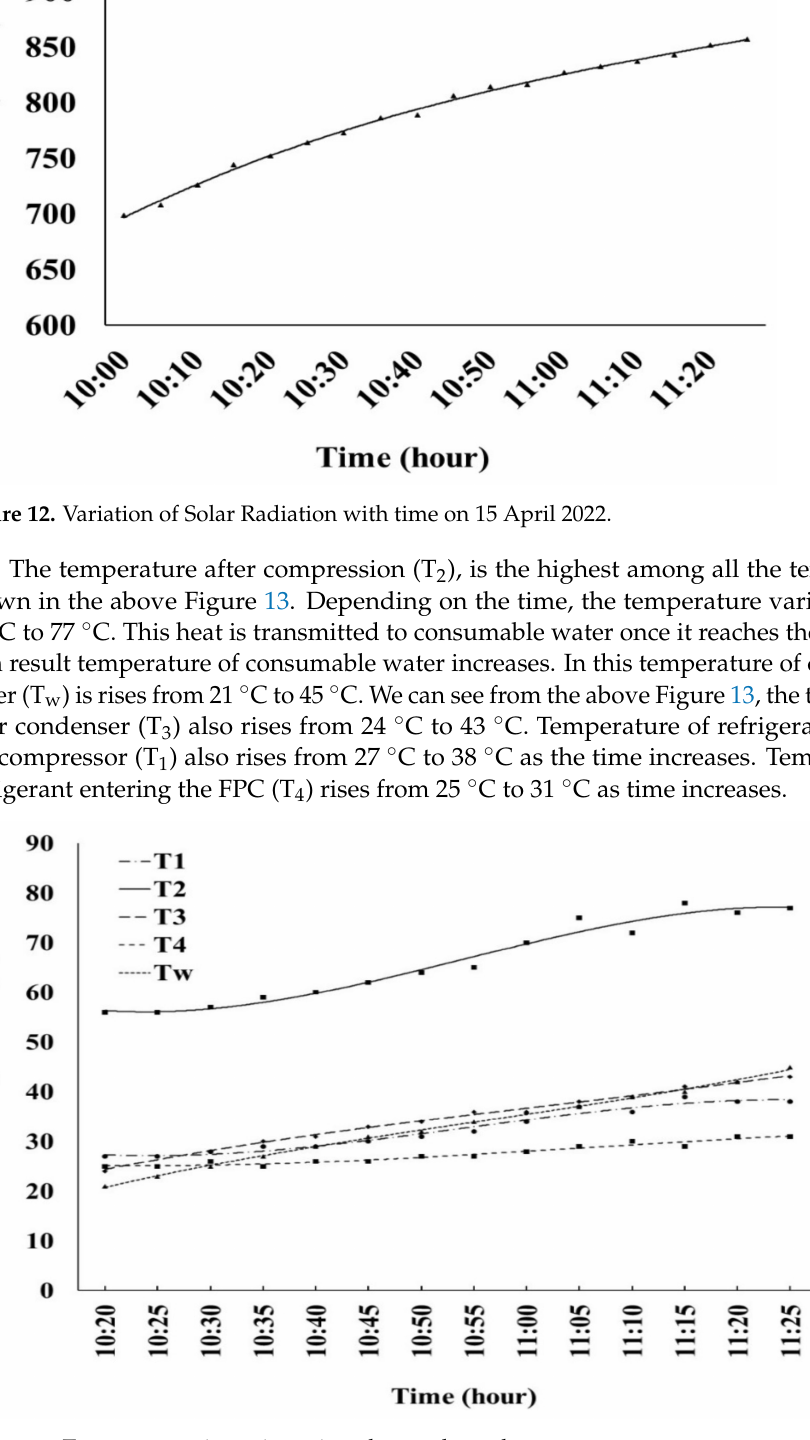
Figure 13. Temperatures in various sites change